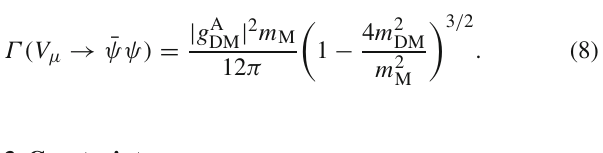
Table 1 A summary of all likelihoods included in our scans